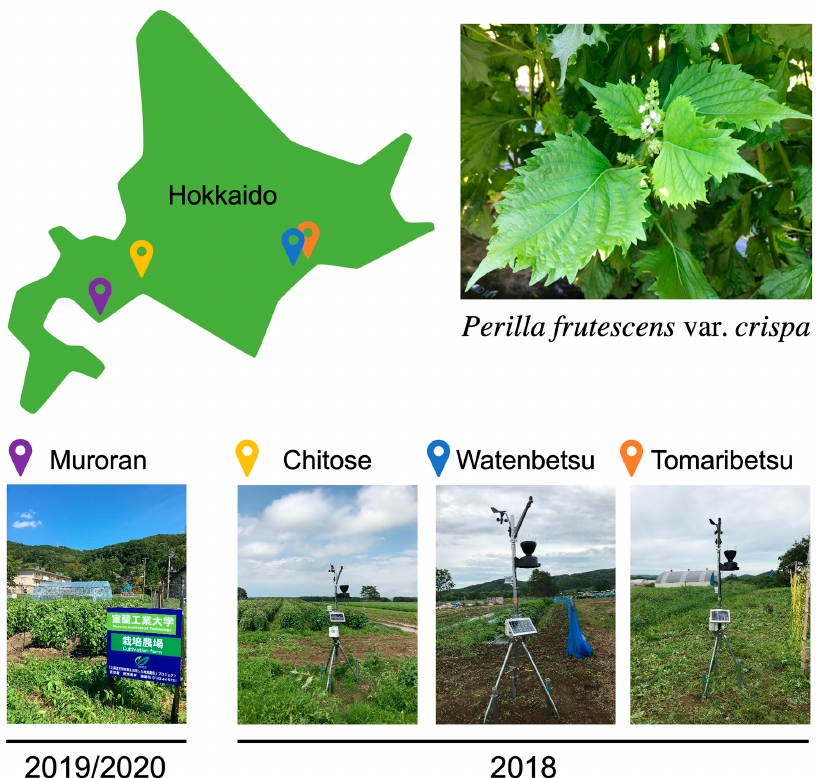
Figure 2. Cultivation of Perilla frutescens var. crispa in four fields in Hokkaido. In 2018, plants were cultivated in three fields (Chitose, Watenbetsu, and Tomaribetsu) in Hokkaido, Japan, where meteorological equipment was installed. In 2019 and 2020, plants were cultivated under multiple conditions in only Muroran.